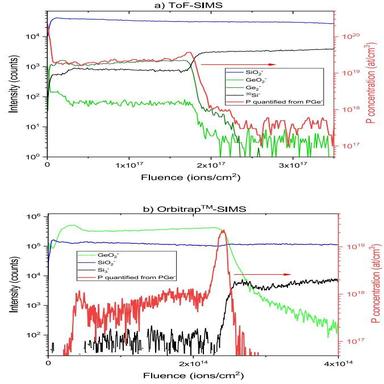
a) ToF-SIMS and b) Orbitrap™-SIMS depth profiles (quantified P using PGe− ) for 20 nm wide fins. The different fluences of the ToF-SIMS and Orbitrap™-SIMS profiles are explained by differences in the respective analysis conditions.